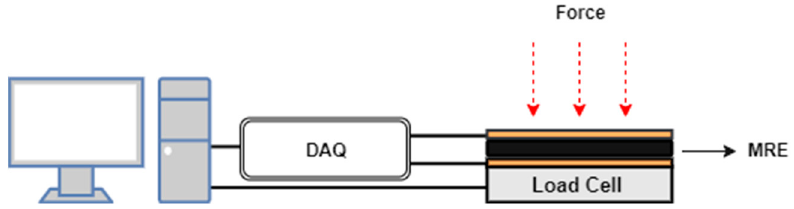
Figure 2. Schematic diagram for resistance testing.